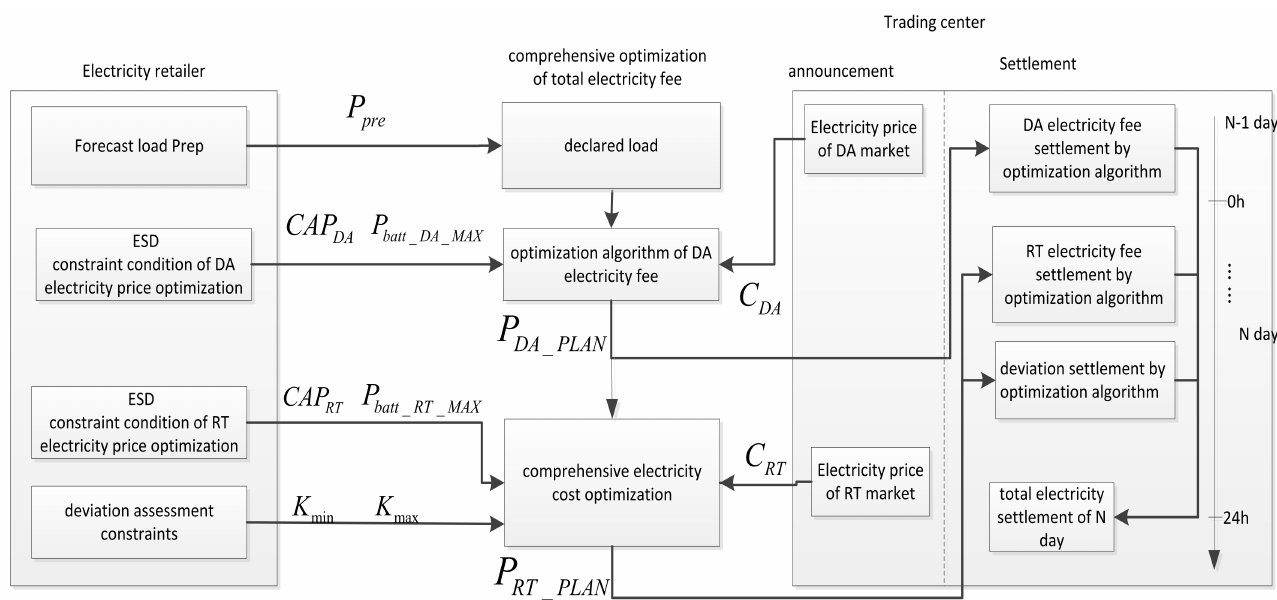
Figure 5. State flow of total electricity cost optimization algorithm of electricity